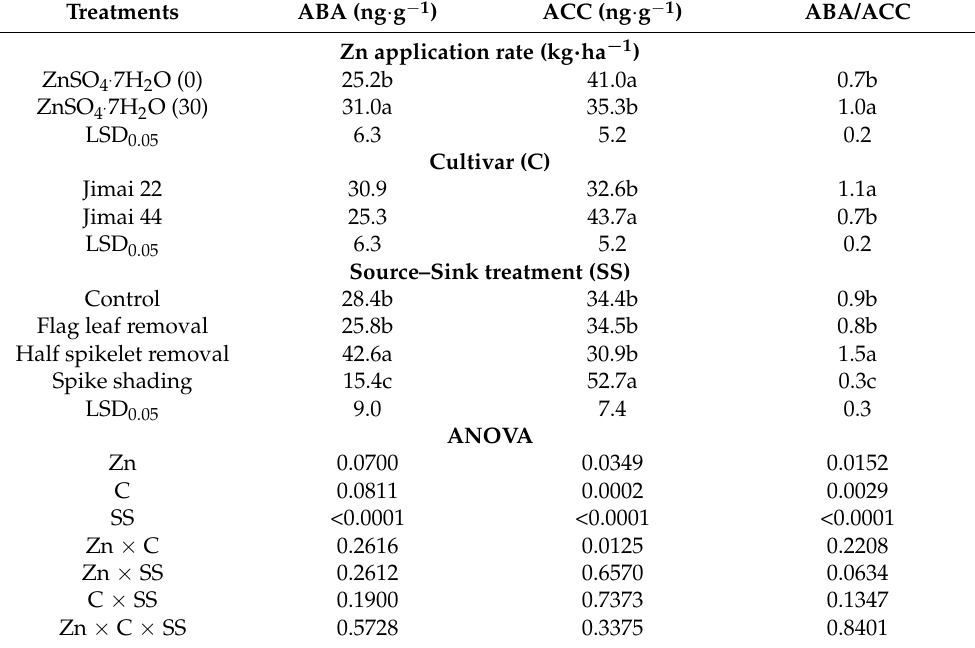
Table 4. Effects of soil Zn application and source–sink manipulations on concentrations of ABA and ACC and ratios of ABA/ACC in grains of different wheat